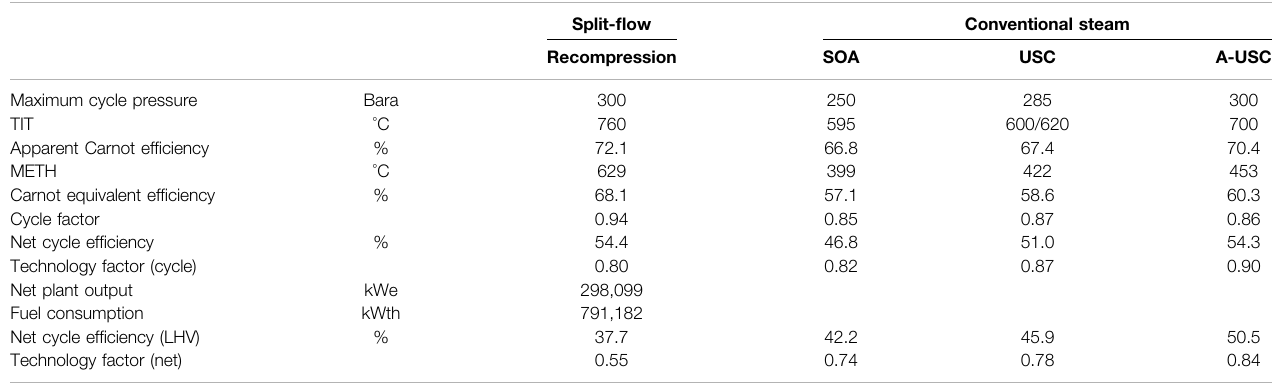
TABLE 9 | Supercritical CO 2 Brayton and Rankine cycles with